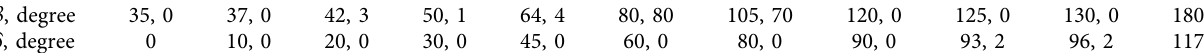
Table 1: Calculated values of the slope angle δ depending on the value of the contact angle β for the Au-Si system. β , degree